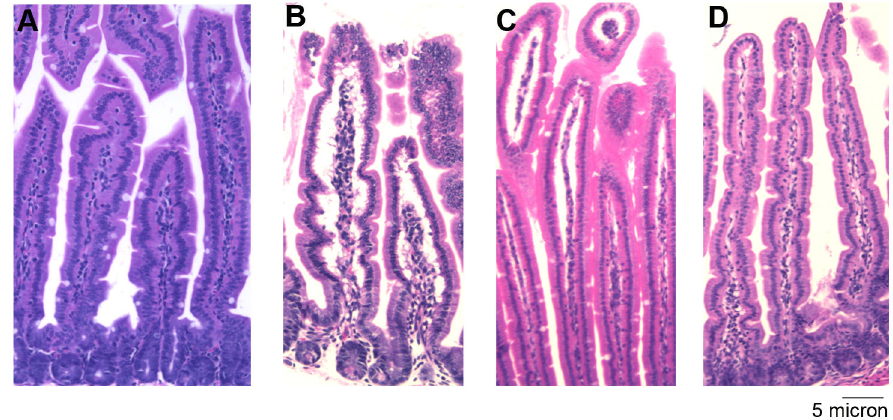
Figure 8. Ricin causes mild damage to the lamina propria in the small intestine. Small intestinal sections from mice orogastrically exposed to 10 mg/kg ricin (A, B, C) or PBS (D) were stained with H&E and assessed for damage at 16 (A), 24 (B, D), and 96 (C) hours. Magnification: 100X. doi: